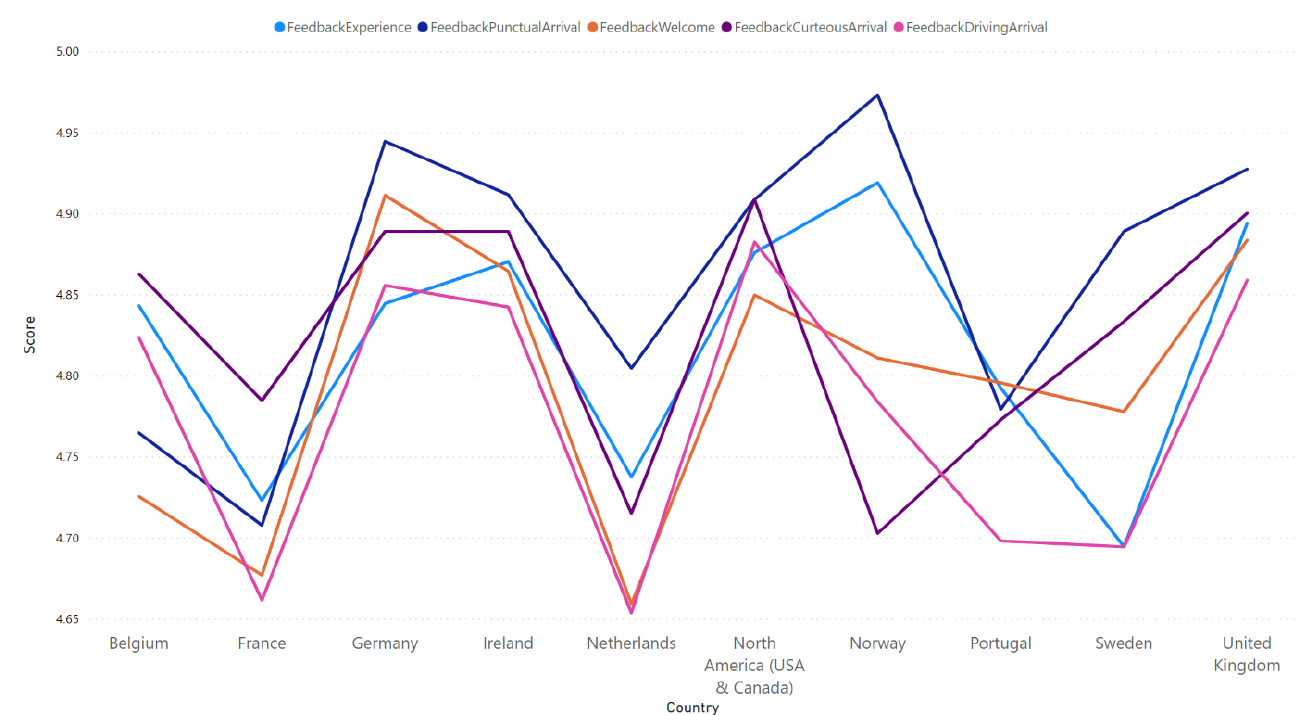
Figure 2. Comparison between the average of FeedbackExperience with the average of Feedback- PunctualArrival, FeedbackWelcome, FeedbackCurteousArrival, and FeedbackDrivingArrival. Table 5. Pearson’s correlation values between the FeedbackWelcome, FeedbackDrivingArrival, FeedbackCourteousArrival, FeedbackPunctualArrival, FeedbackWebsite, Npax, Km variables, and FeedbackExperience.